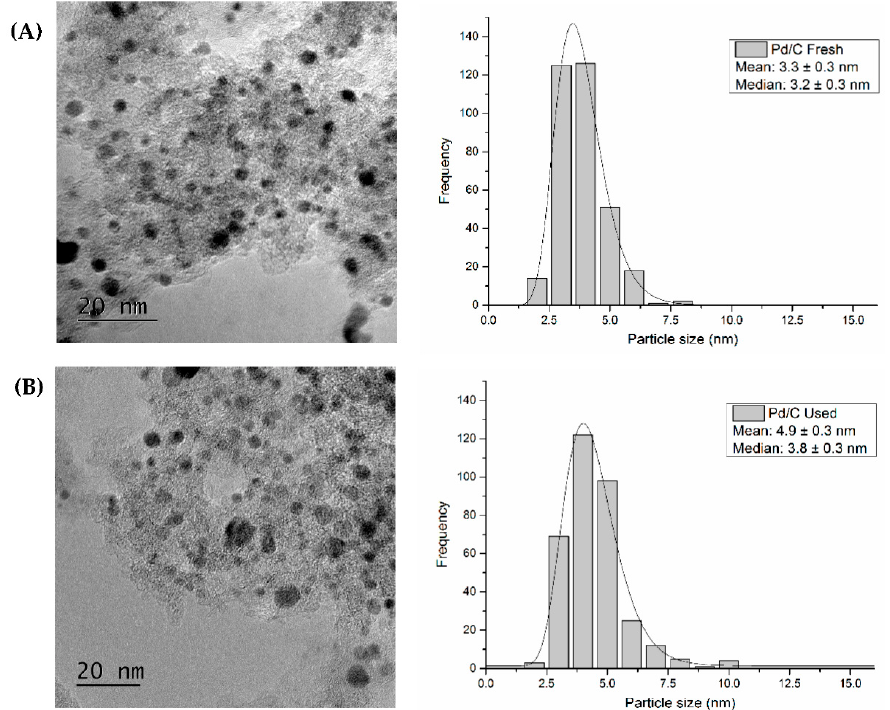
Figure 12. Characterisation of fresh and used 5 wt.% Pd/C catalyst and corresponding histograms of the particle size distributions. Magnification: ×250 k, ( A ) Fresh 5 wt.% Pd/C, ( B ) Used 5 wt.%